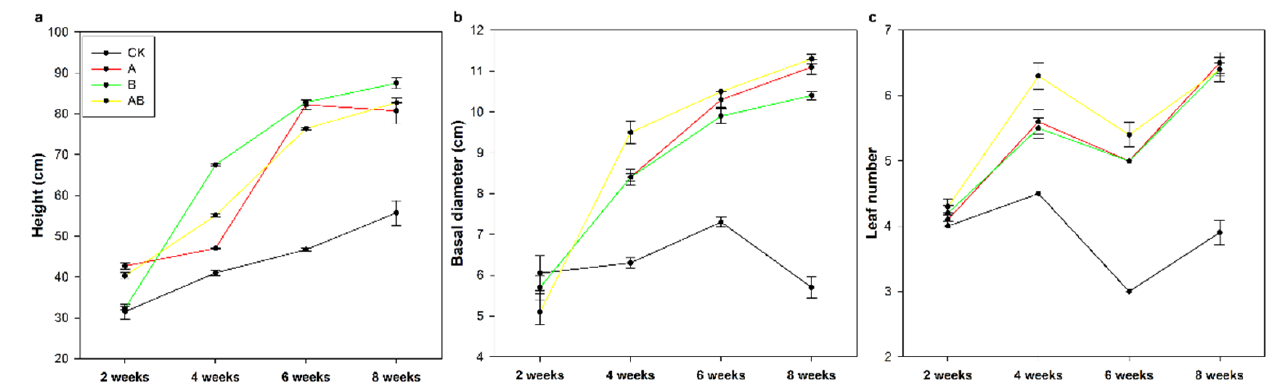
Figure 2. Effects of arbuscular mycorrhizal fungi and biochar on ( a ) maize height, ( b ) basal diameter, and ( c ) leaf number. Data are means of five replicates ± SEs. CK, control; A, arbuscular mycorrhizal fungi; B, biochar; AB, arbuscular mycorrhizal fungi and biochar.